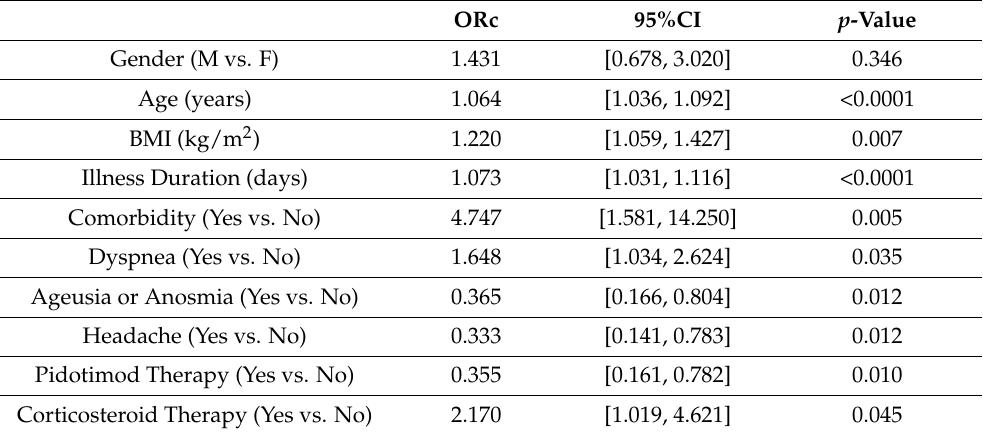
Table 4. Crude odds ratio and corresponding 95% CI for ER access/hospitalization.